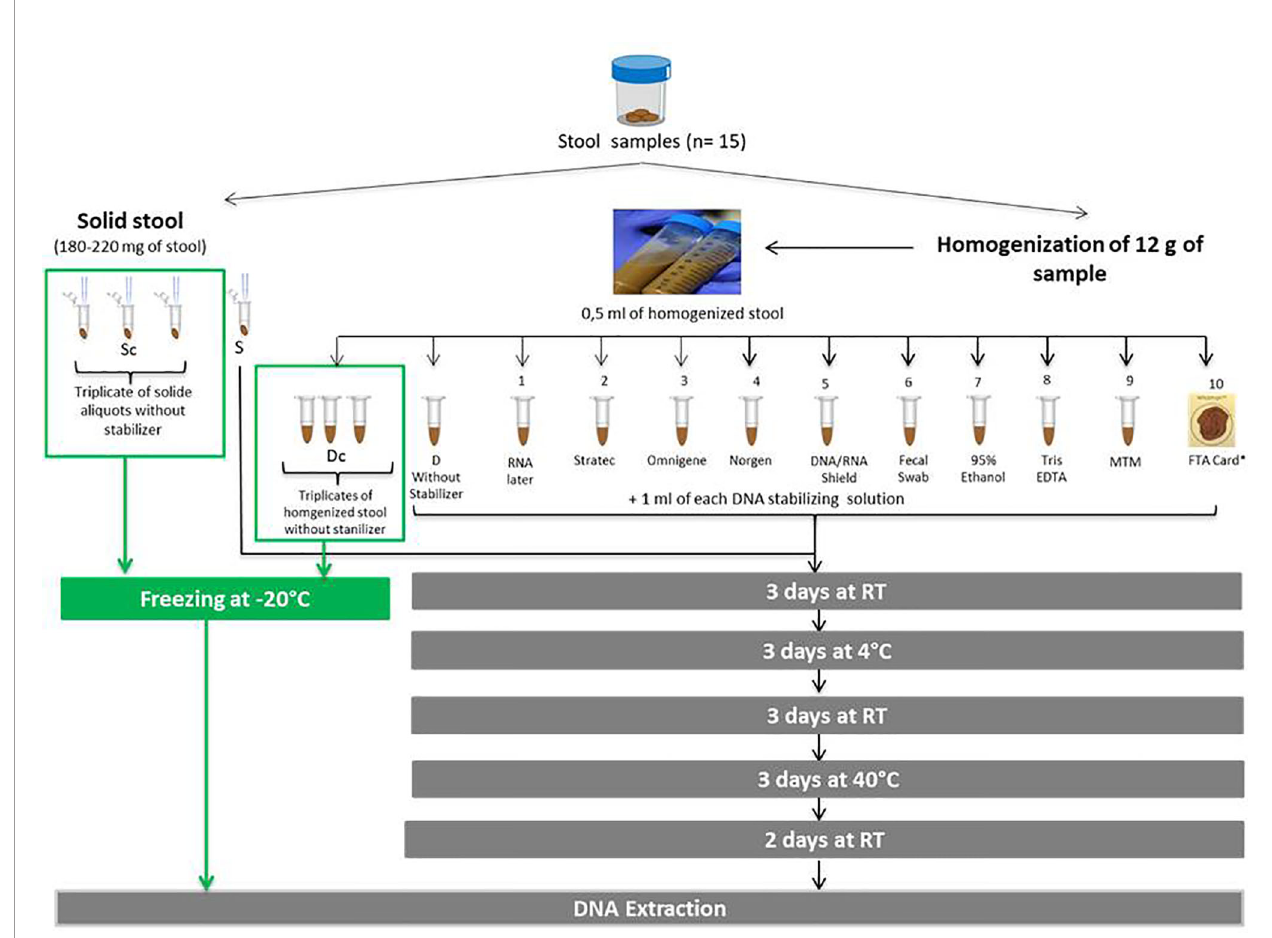
FIGURE 1 | Illustration of the experimental protocol. Evaluation of ten commercial DNA stabilizing solutions for the storage of fecal samples. (Sc, frozen solid sample; Dc, frozen homogenized sample; S, solid sample without stabilizer; D:, homogenized sample without stabilizer; RT, room temperature). * The whatman FTA card is a cotton-based cellulose matrix containing chemicals that lyse cells, denature proteins and protect DNA; 0.5 ml of homogenized solution was dispatched directly onto the